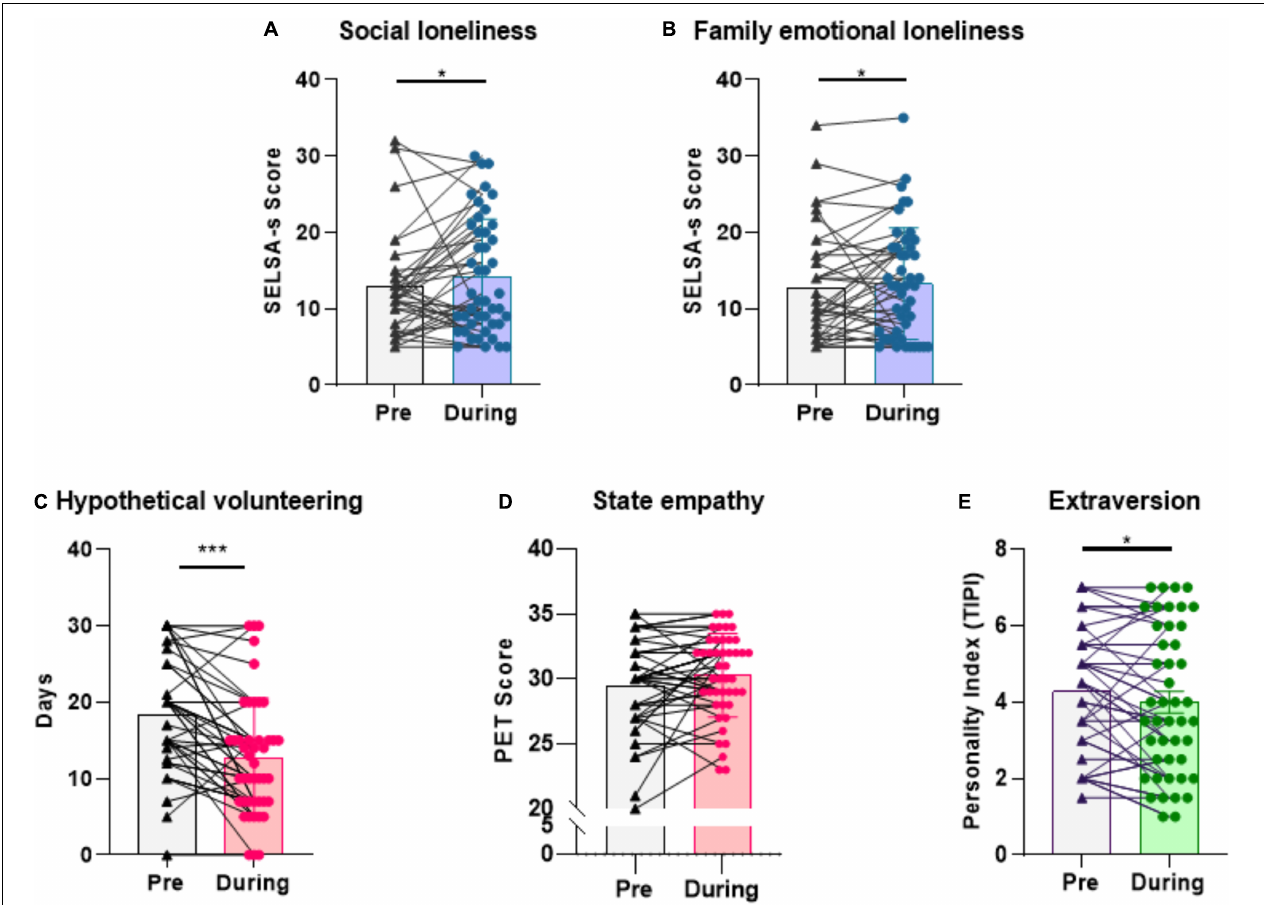
FIGURE 3 | Pre-confinement and during-confinement scores. Bar graphs showing (A) an increase in Social loneliness (B) an increase in Family emotional loneliness (C) a decrease in number of days dedicated to a hypothetical volunteering choice (D) no change in scores on state empathy and (E) a decrease in extraversion scores as measured by the TIPI. SELSA-S, Social and Emotional Loneliness Scale-Short; PET, Pictorial Empathy Test; TIPI, Ten-Item Personality Index. * p < 0.05; *** p <